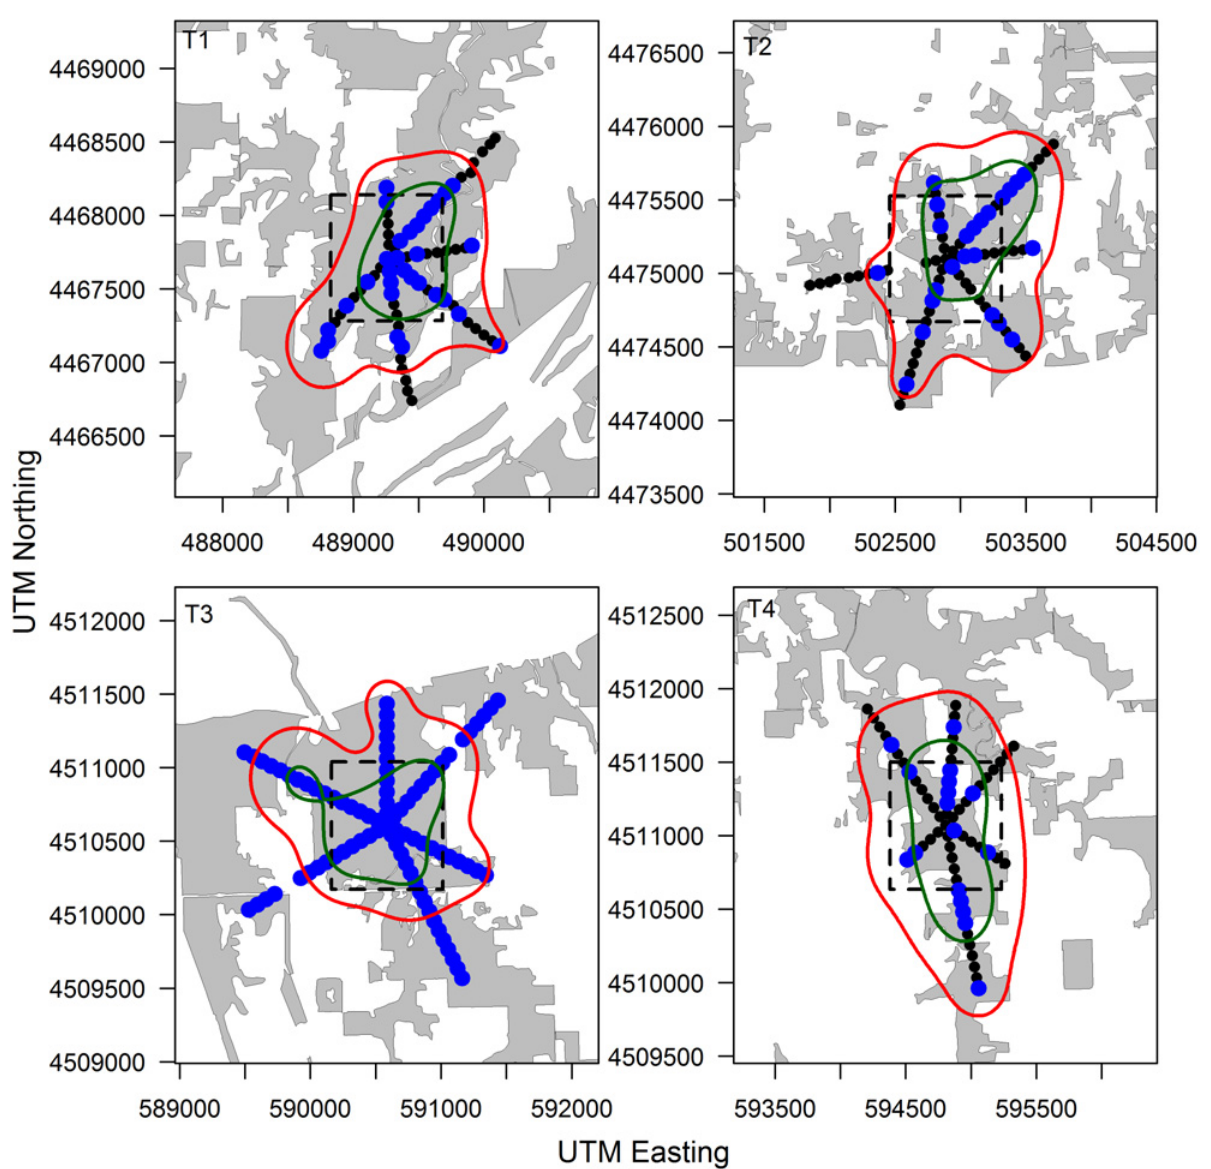
Figure 3. Configuration of treatment site trapping webs illustrating the distribution of Rhodamine B marked captures (blue), the bait distribution zone (dashed line), and 90% (red) and 50% (green) utilization distributions estimated from the distribution of Rhodamine B marked raccoons. Transects were oriented through forested areas (gray) and did not extend into agricultural areas (white) based on limited use of agricultural interiors by raccoons in our study area. Each panel represents a unique study site where Rhodamine B baits were placed in a stratified distribution within the bait distribution zone (dashed line) based on raccoon resource selection patterns in our study